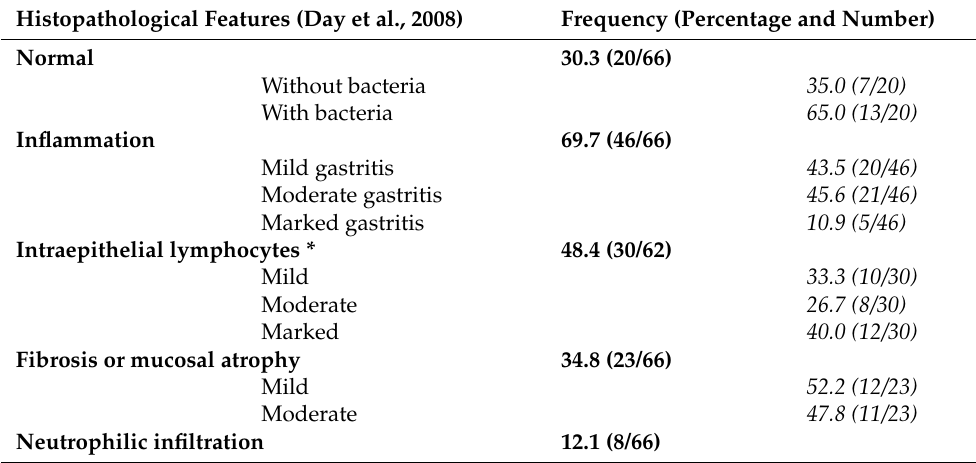
Table 2. Results of histopathological evaluation of feline gastric samples.